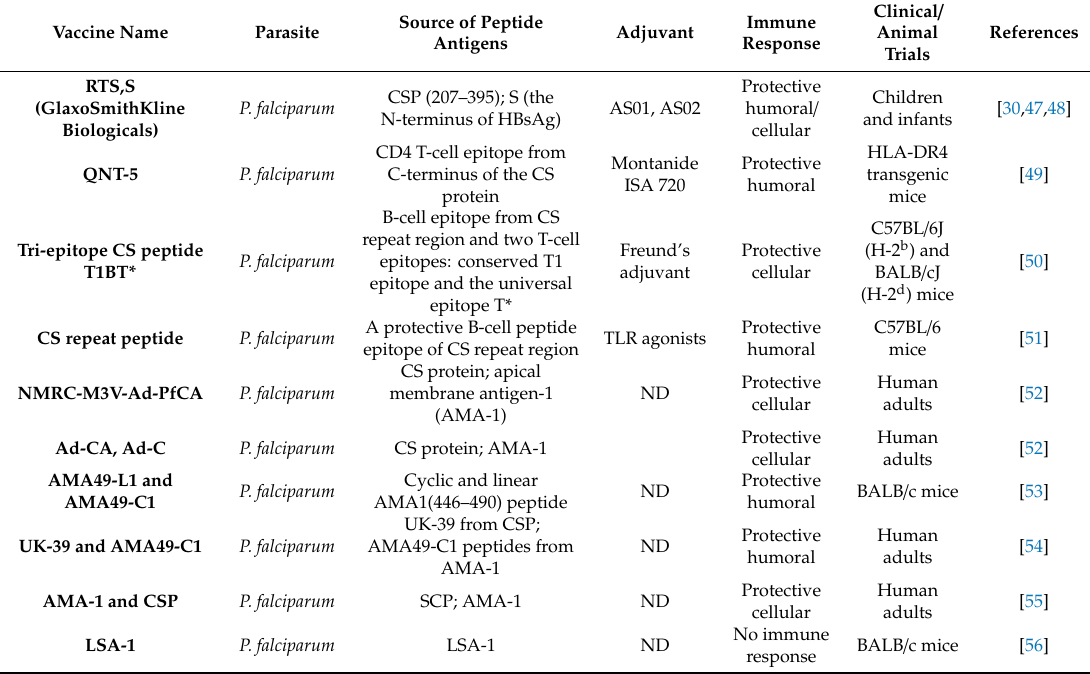
Table 1. Pre-erythrocytic peptide-based vaccine constructs against